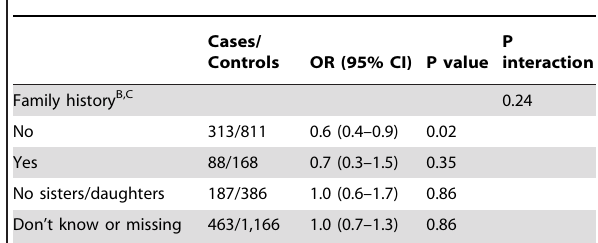
Table 3. Per-allele odds ratios (OR) and 95% confidence intervals (CI) at DCN rs3138165 with serous epithelial ovarian cancer across strata of risk